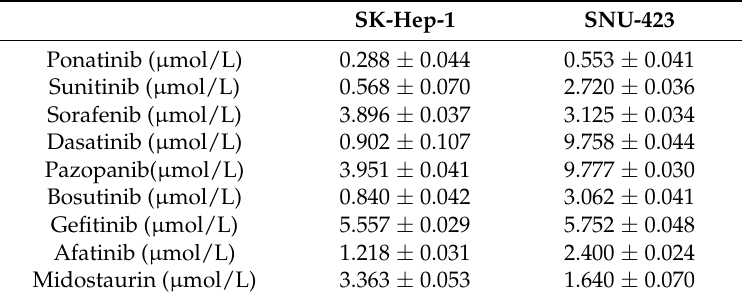
Table 2. The IC 50 ( µ mol/L) of different single agents in HCC cell